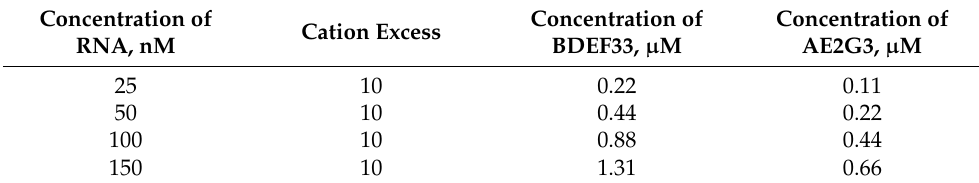
Table 1. Concentrations of complex components being used in the study.